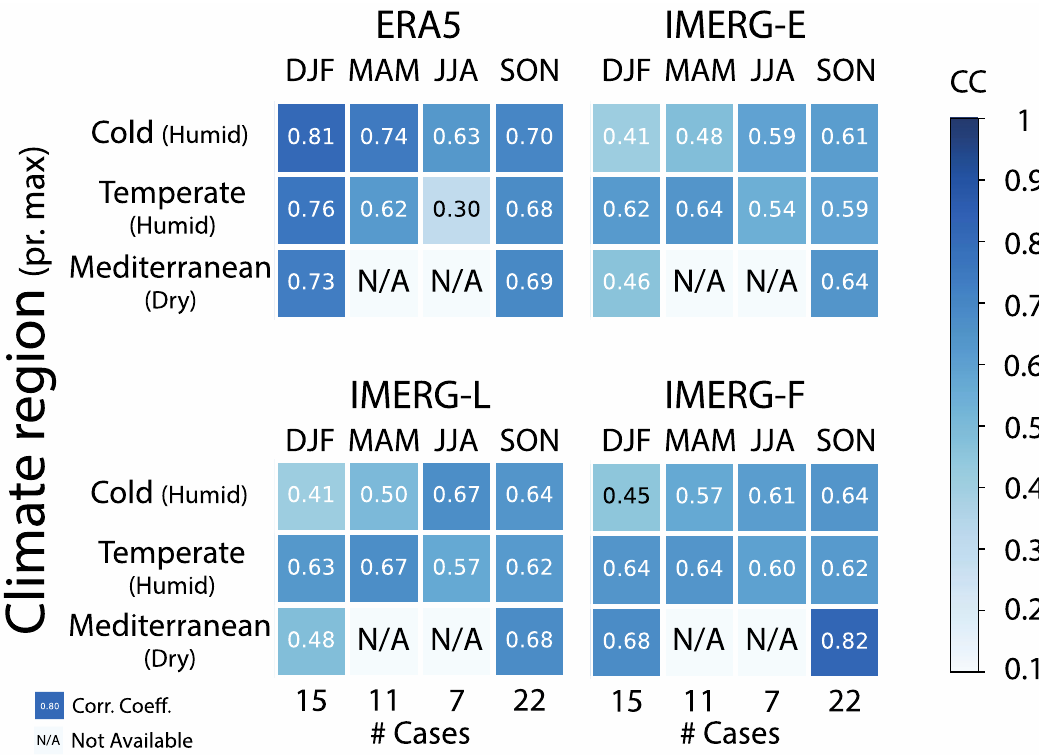
Figure 10. Heat maps of the correlation between gauges, IMERG products, and ERA5-L, ordered according to season and climate region. We assumed that the center of EPE includes maximum rainfall pixels and defines the climate region that is most affected by each EPE. N/A means no cases. Climate regions are grouped in three categories: Cold climates (Dfc and Dfb), temperate climates (Cfa, Cfb), and Mediterranean climates (Csa and Csb).